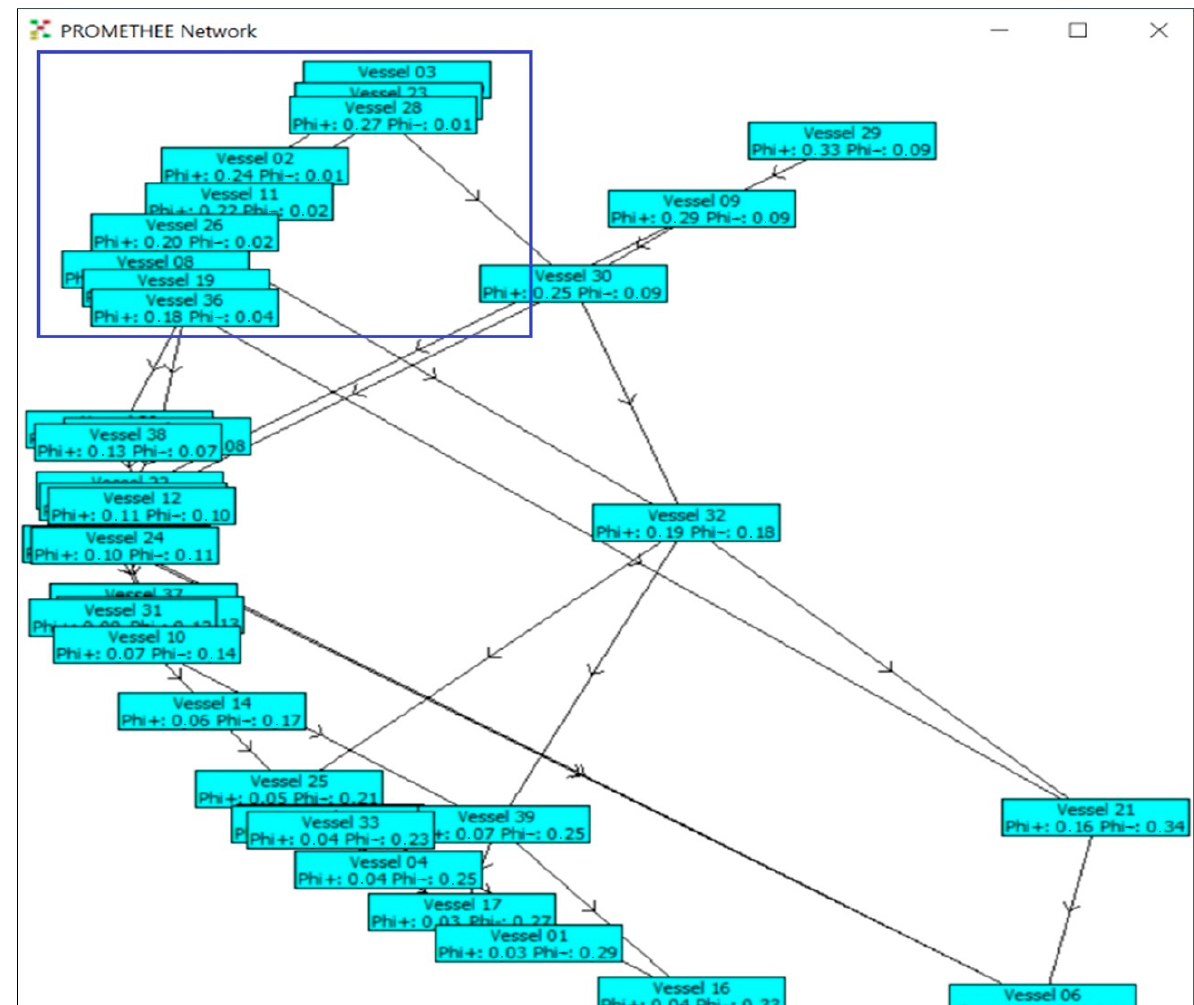
Figure 9. Promethee network (own work on the basis of the Visual Promethee